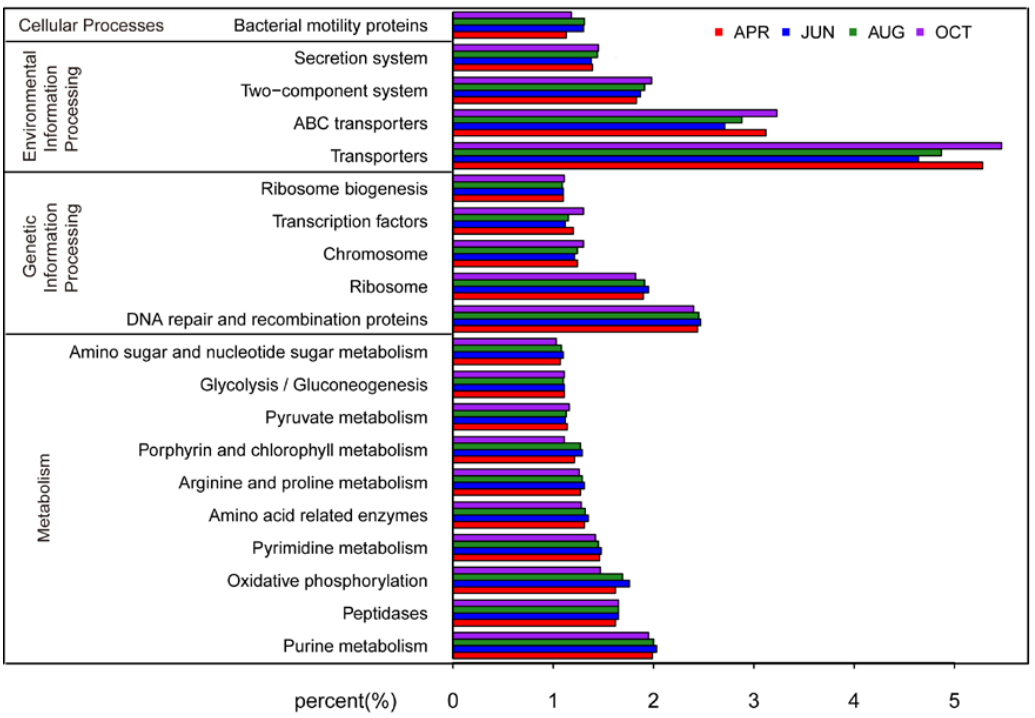
Figure 8. Multiple essential environmental process predictions of the bacterial communities in the Miyun Reservoir using PICRUSt.